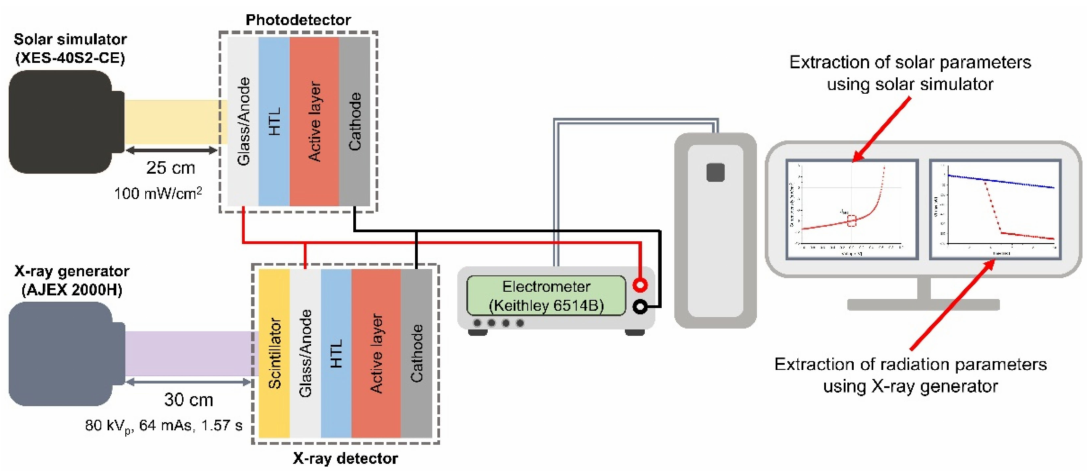
Figure 3. Schematic of the experimental set-up for extracting the photodetector and radiation detector